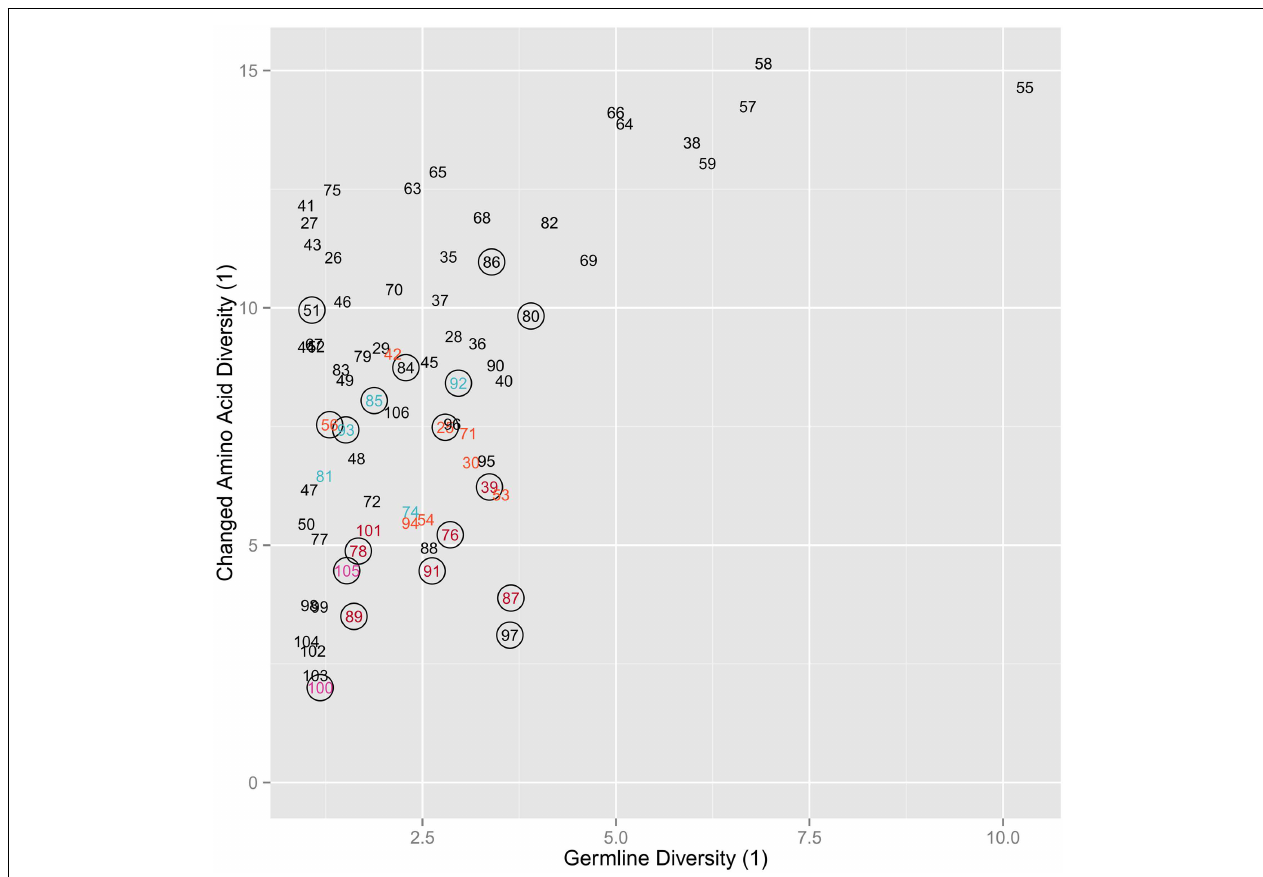
hydrophilic (blue), or indeterminate (black), while a circle around the position indicates that the position shares the same hydrophobicity bias as the equivalent germline position. All amino acids are